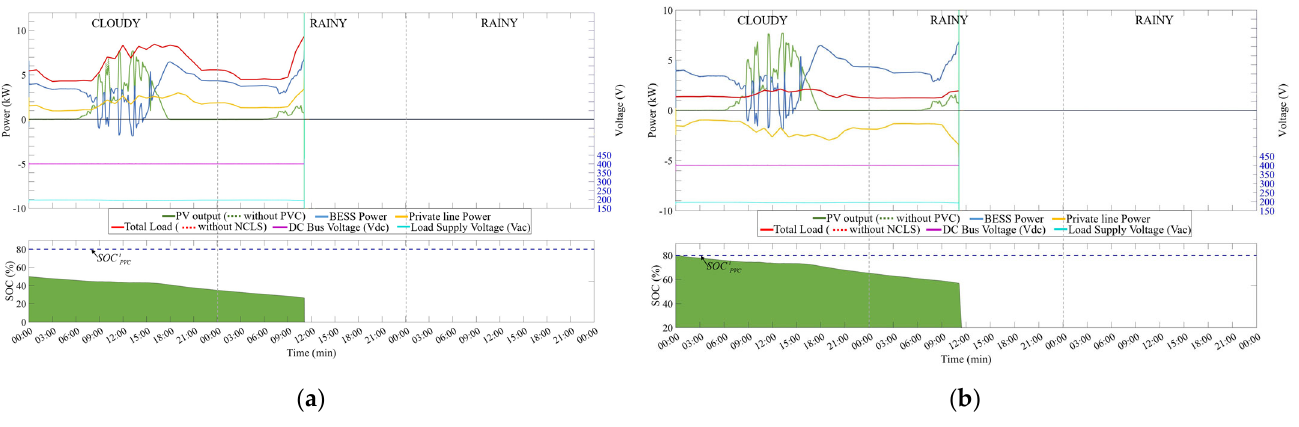
Figure 11. Test case 2 (Disconnected). ( a ) Performance of prosumer X. ( b ) Performance of prosumer Y.